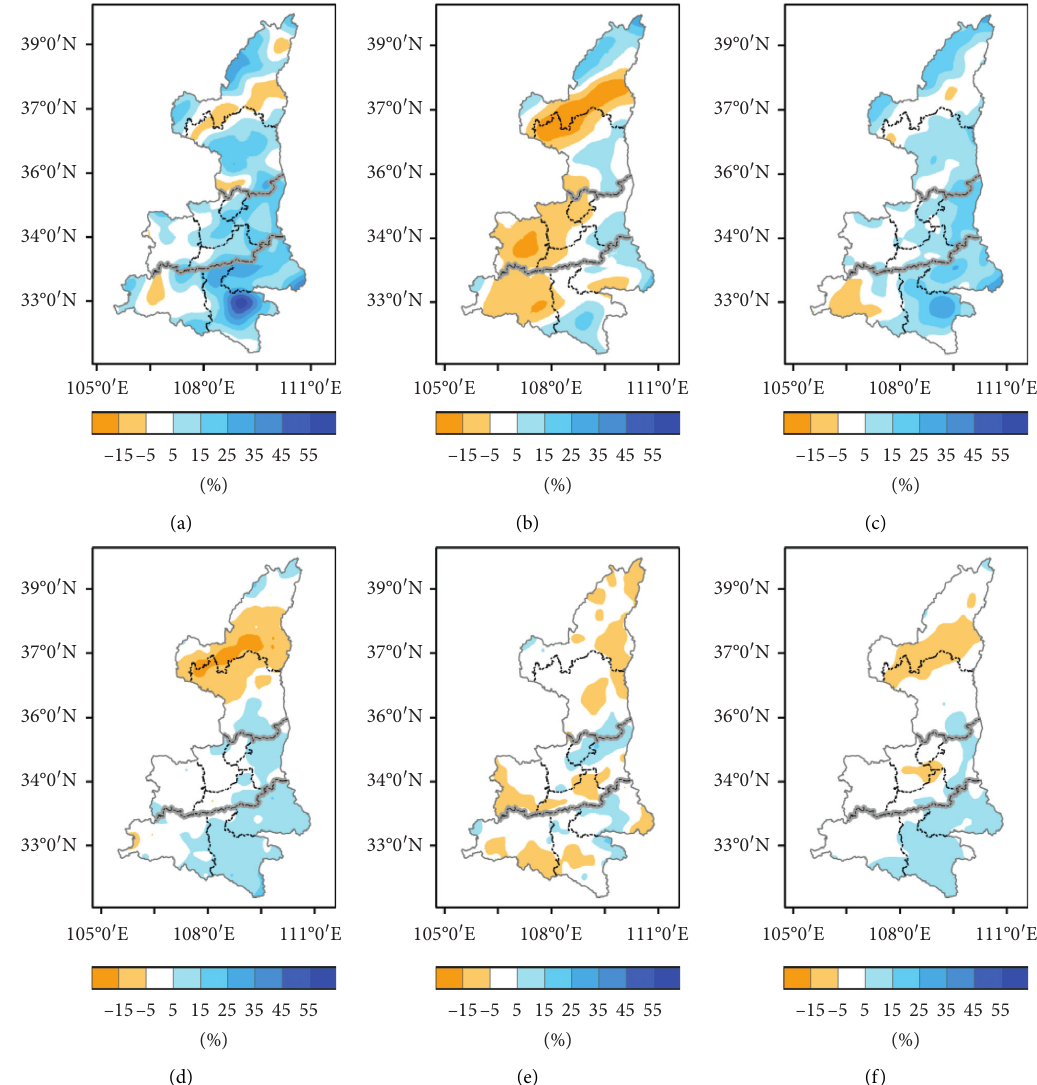
Figure 9: Spatial changes of six EPIs over Shaanxi Province for the end of the 21st century (relative to 1986–2005): (a) Rx1day; (b) Rx5day; (c) R95p; (d) R10 mm; (e) CDD; (f)